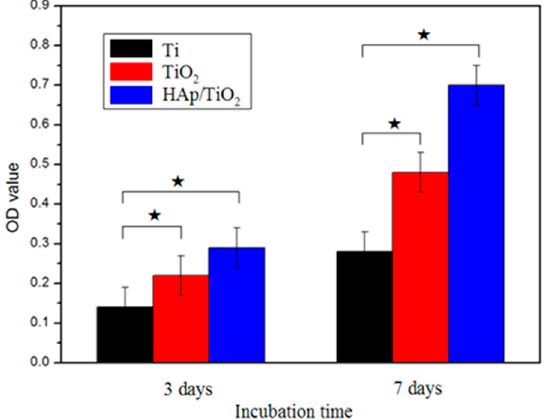
Figure 10. Optical density measurements showing mesenchymal stem cell proliferation on pure Ti, TiO 2 nanotubes, and nanoscale HA coating on TiO 2 nanotubes after culture for 3 and 7 days.